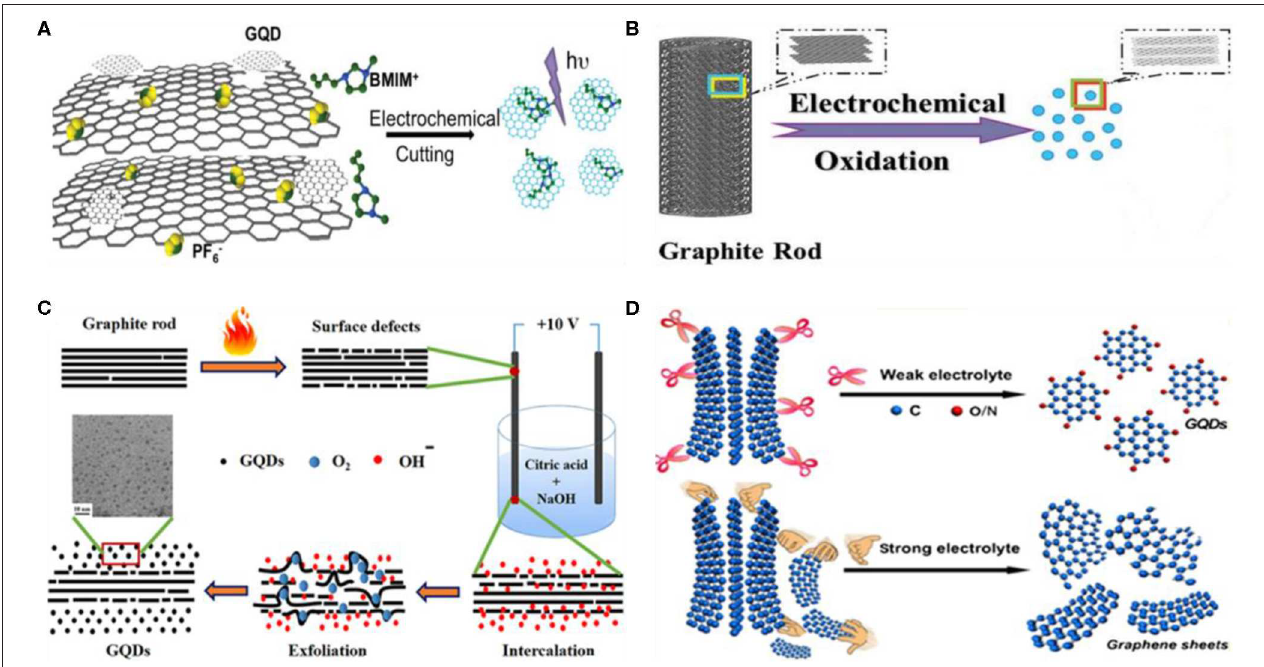
FIGURE 3 | Illustration of GQD fabrication by electrochemical approach using 3D porous graphene (A) ; reproduced from Ananthanarayanan et al. (2014), with permission from Wiley. (B,C) Graphite rods; reproduced from Su et al. (2015) and Ahirwar et al. (2017) with permission from Wiley and American Chemical Society. (D) Graphene paper; reproduced from Huang et al. (2018) with permission from the American Chemical